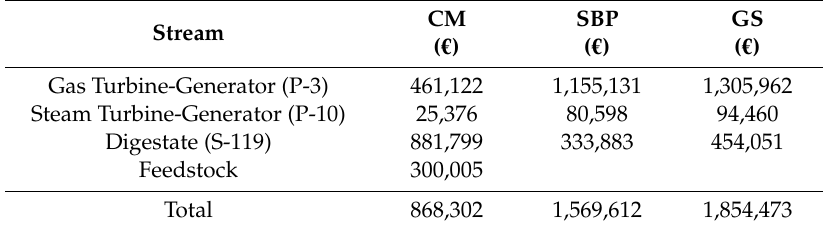
Table 14. Revenues ( € ) per year of a biogas power plant including a subsidy of 20 € /